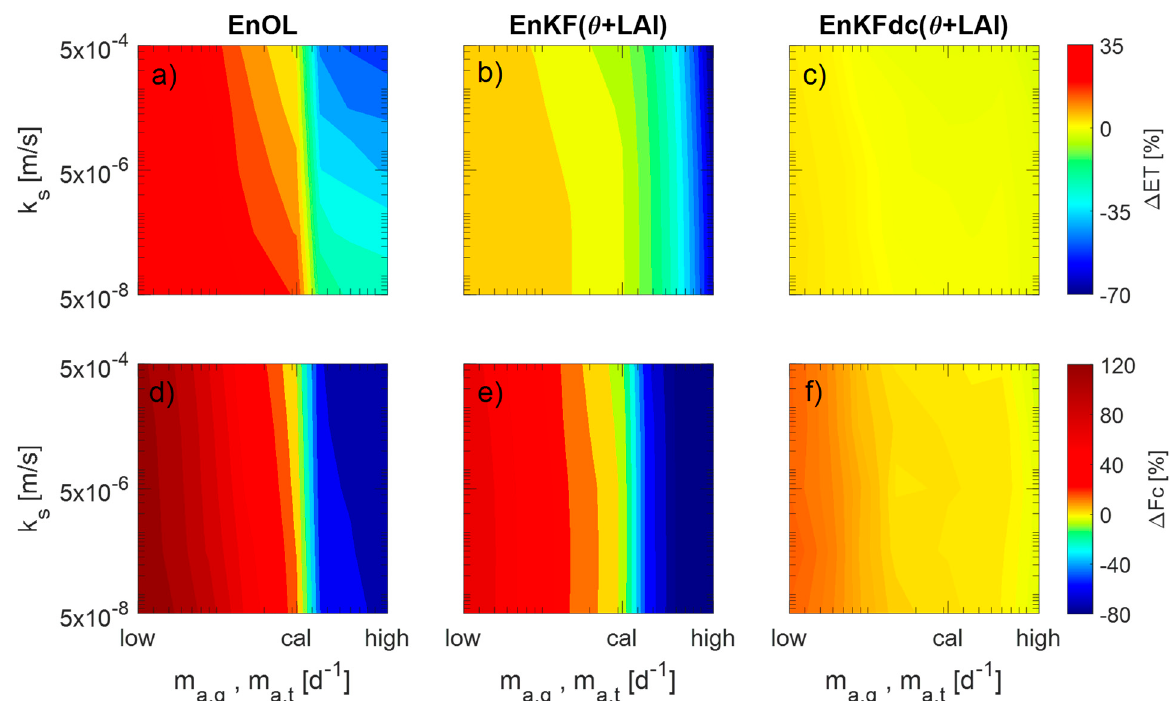
Figure 8. The errors in total evapotranspiration (ET) and carbon exchange ( F c ) predictions using the EnOL ( a , d ), EnKF ( b , e ), and EnKFdc ( c , f ) approaches, with varied initial ˆ m a , g , ˆ m a , t , and ˆ k s values (low m a,g and m a,t values correspond to 0.0032 d − 1 and 0.0001 d − 1 , respectively, while high m a,g and m a,t values correspond to 0.12 d − 1 and 0.01 d − 1 , respectively; cal—calibrated values), compared with ET and F c observations from the eddy-covariance-based